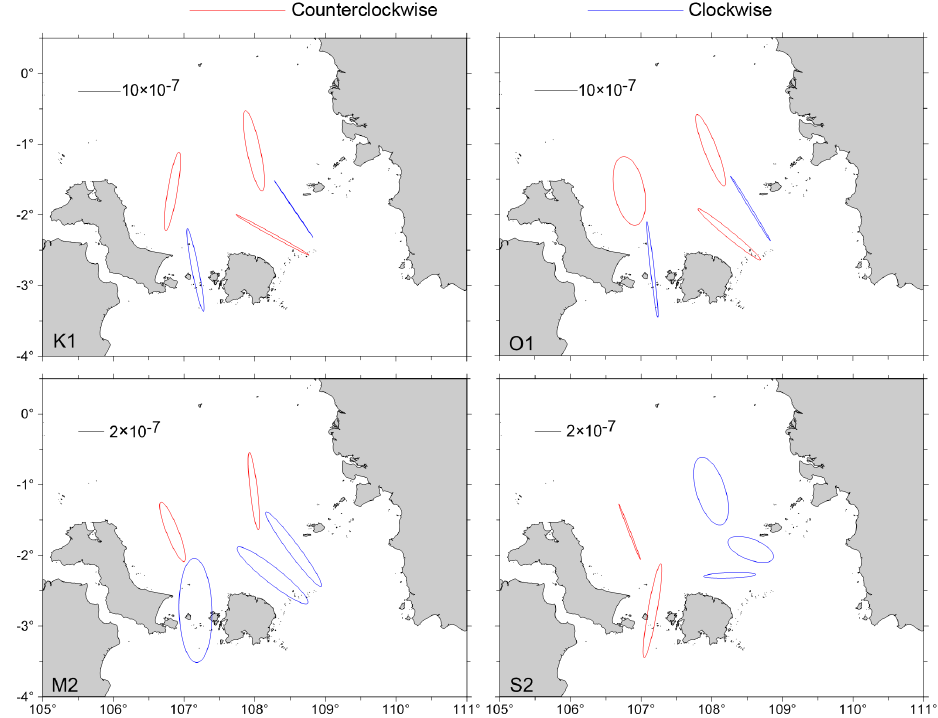
Figure 5. The tidal elevation gradient ellipses of K 1 , O 1 , M 2 , and S 2 at the observational stations.